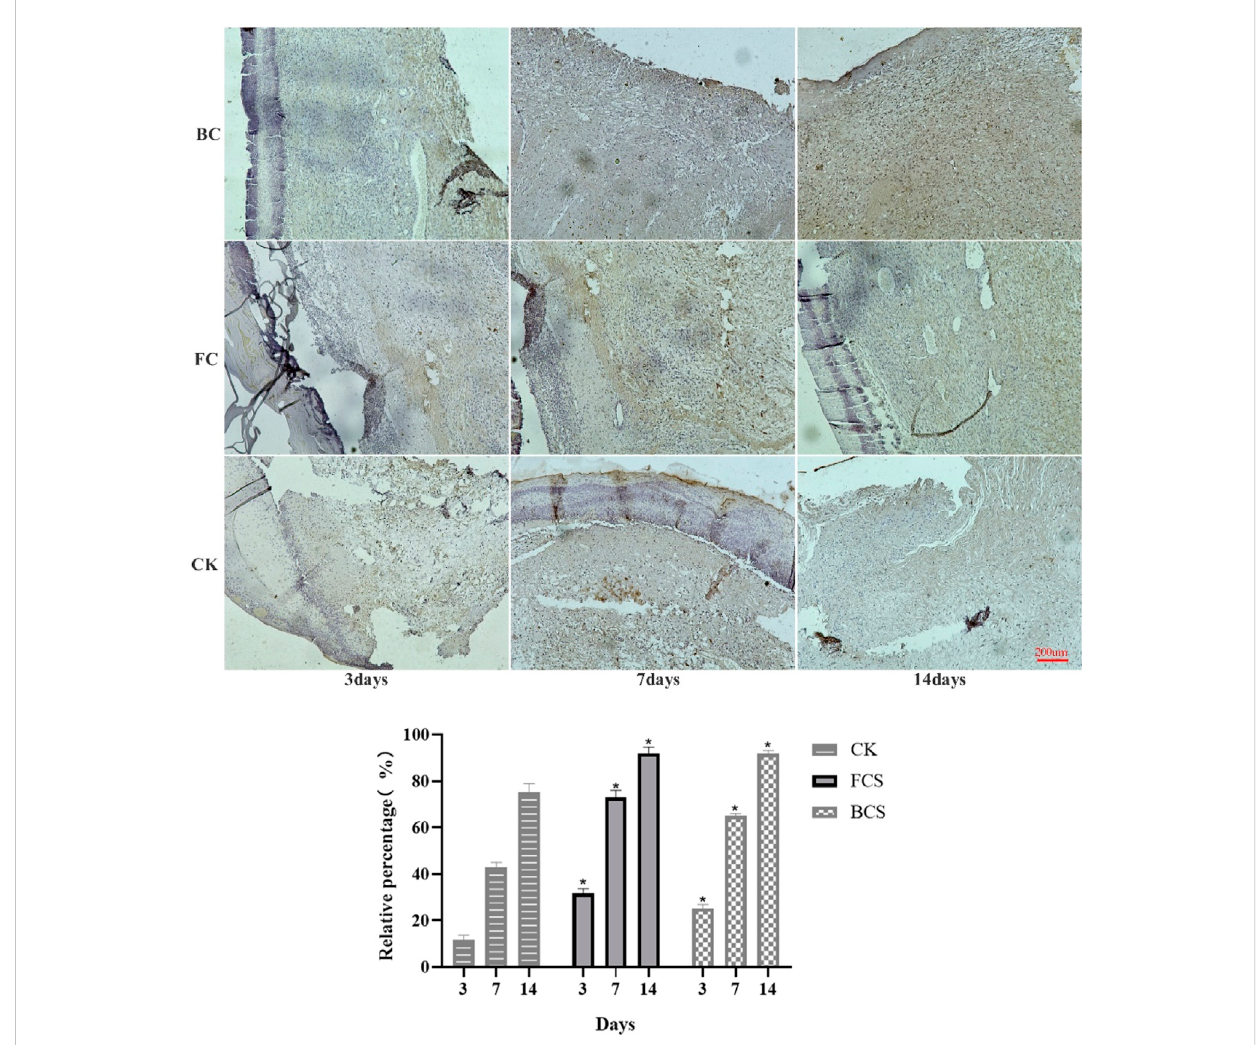
FIGURE 7 Immunohistochemical analysis of FGF expression in wounded tissues (Magni fi cation, ×100) Note: FGF is mainly expressed in fi broblasts, which are coloredduringimmunohistochemistryanddistributedinthesurface,middleandbottomlayers.Thehistogramshowedthetotalofpositivelystainedcells of FGF in the dermal tissue per group. (Each bar represents the mean ± SD; * p < 0.05: signi fi cantly different from the control